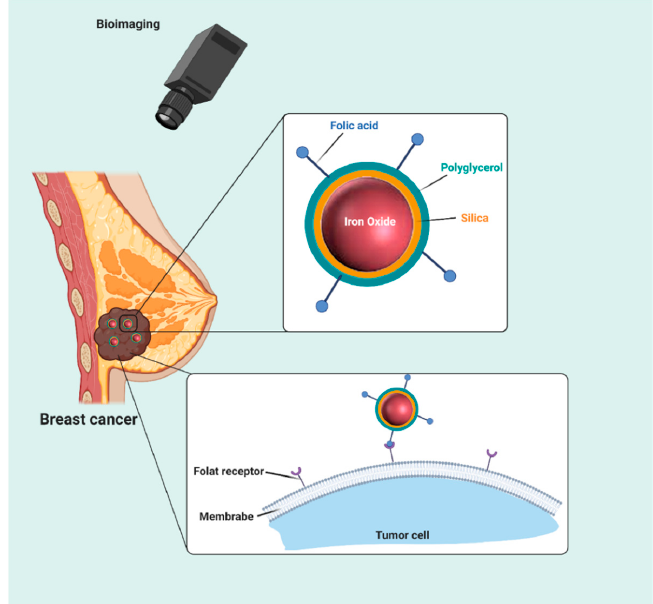
Figure 9. Schematic representation of using nanoparticles for selective targeting of breast cancer cells.